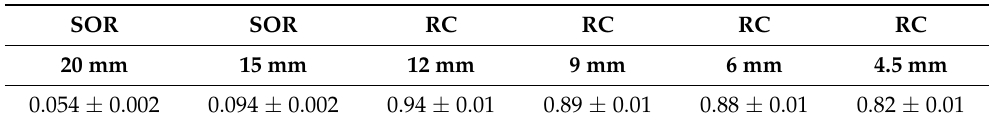
Table 8. RC and SOR values for different rods. The SOR is calculated on bigger cold rods (20 and 15 mm), while RC is calculate on the remaining hot rods